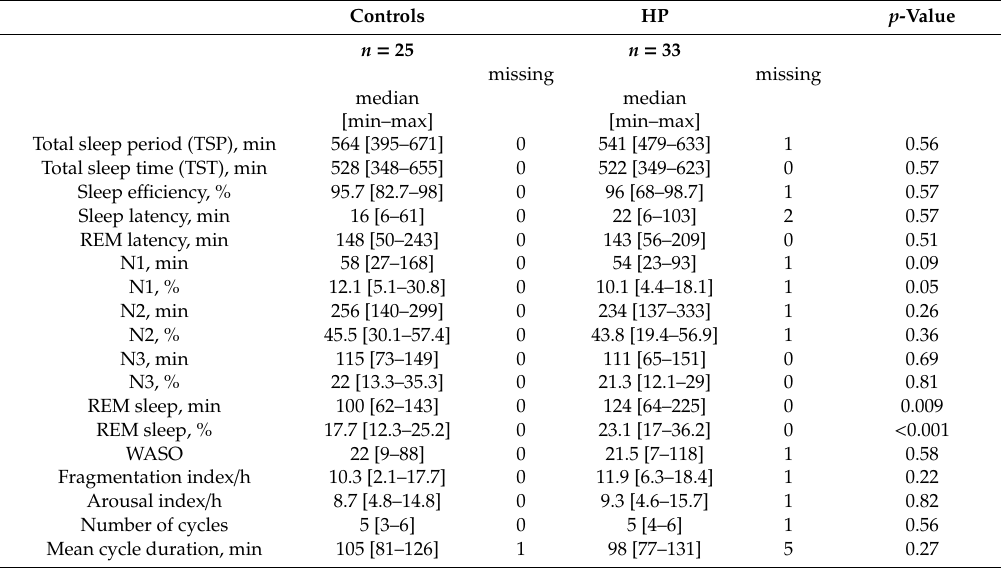
Table 2. Characteristics of the Polysomnography (PSG) for children with HP and controls. Controls HP p -Value n = 33